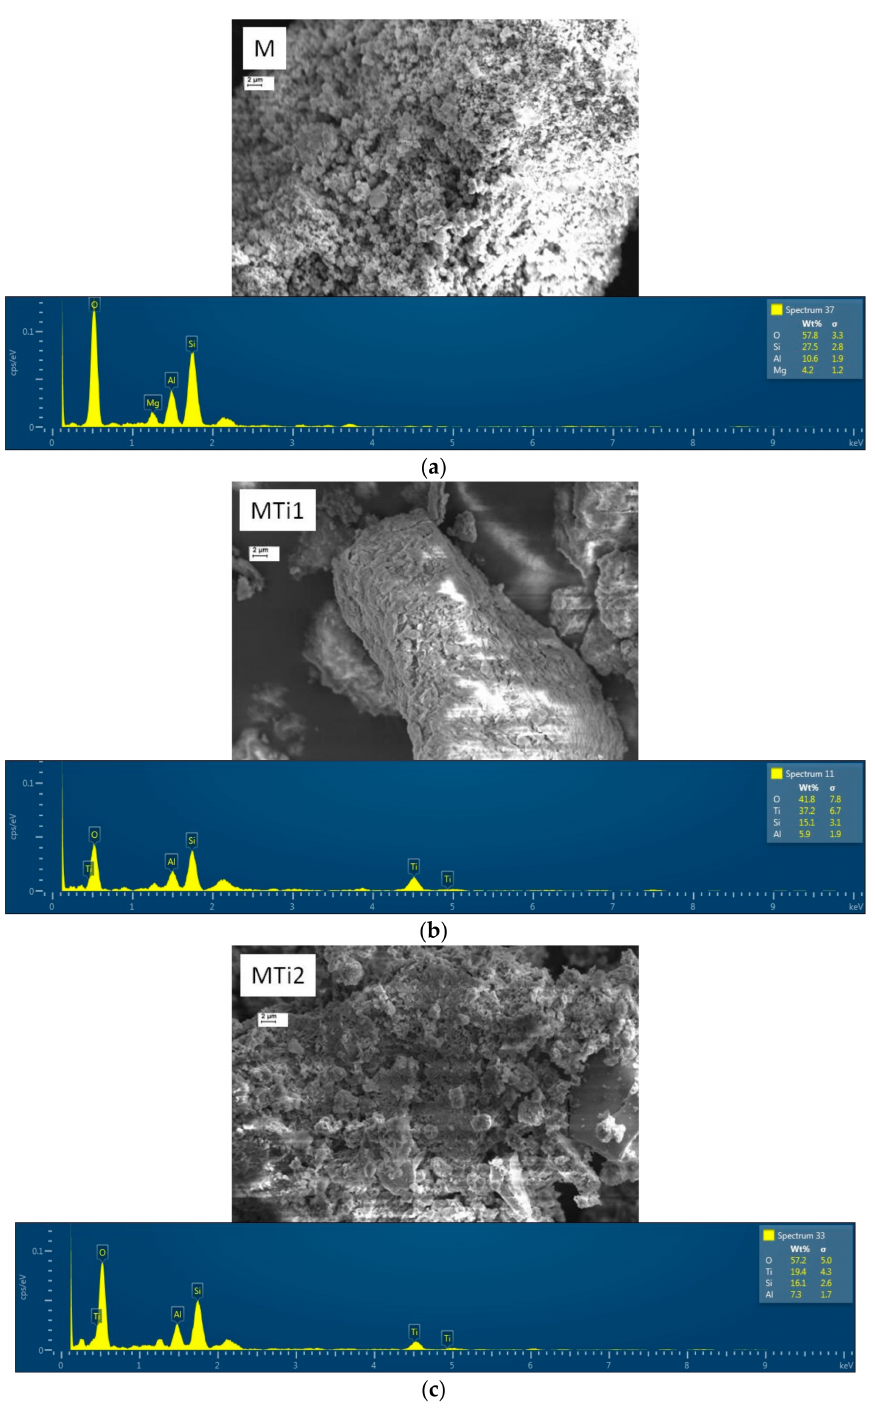
Figure 6. SEM micrographs and point analyses of the parent montmorillonite and the prepared nanocomposites: Montmorillonite ( a ); MTi1 ( b ); and MTi2 ( c )